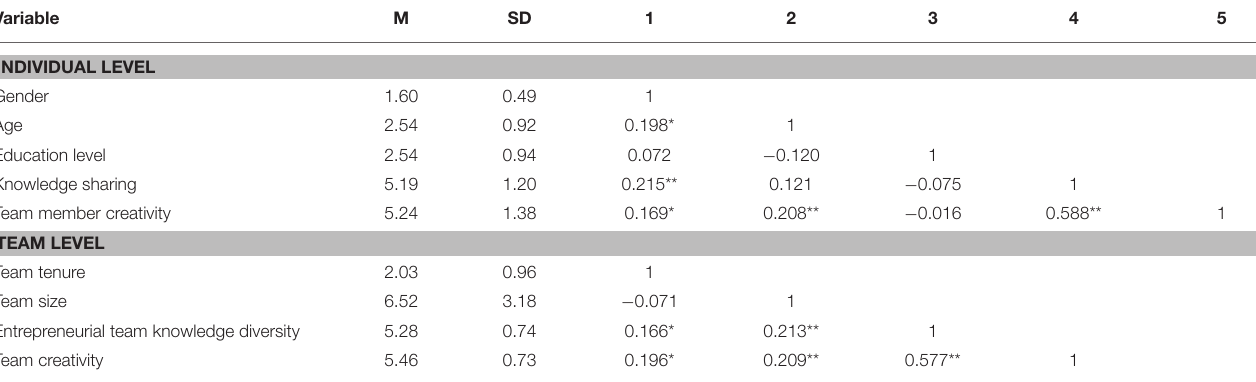
TABLE 1 | Means, standard deviations, and inter-correlations of variables. Variable